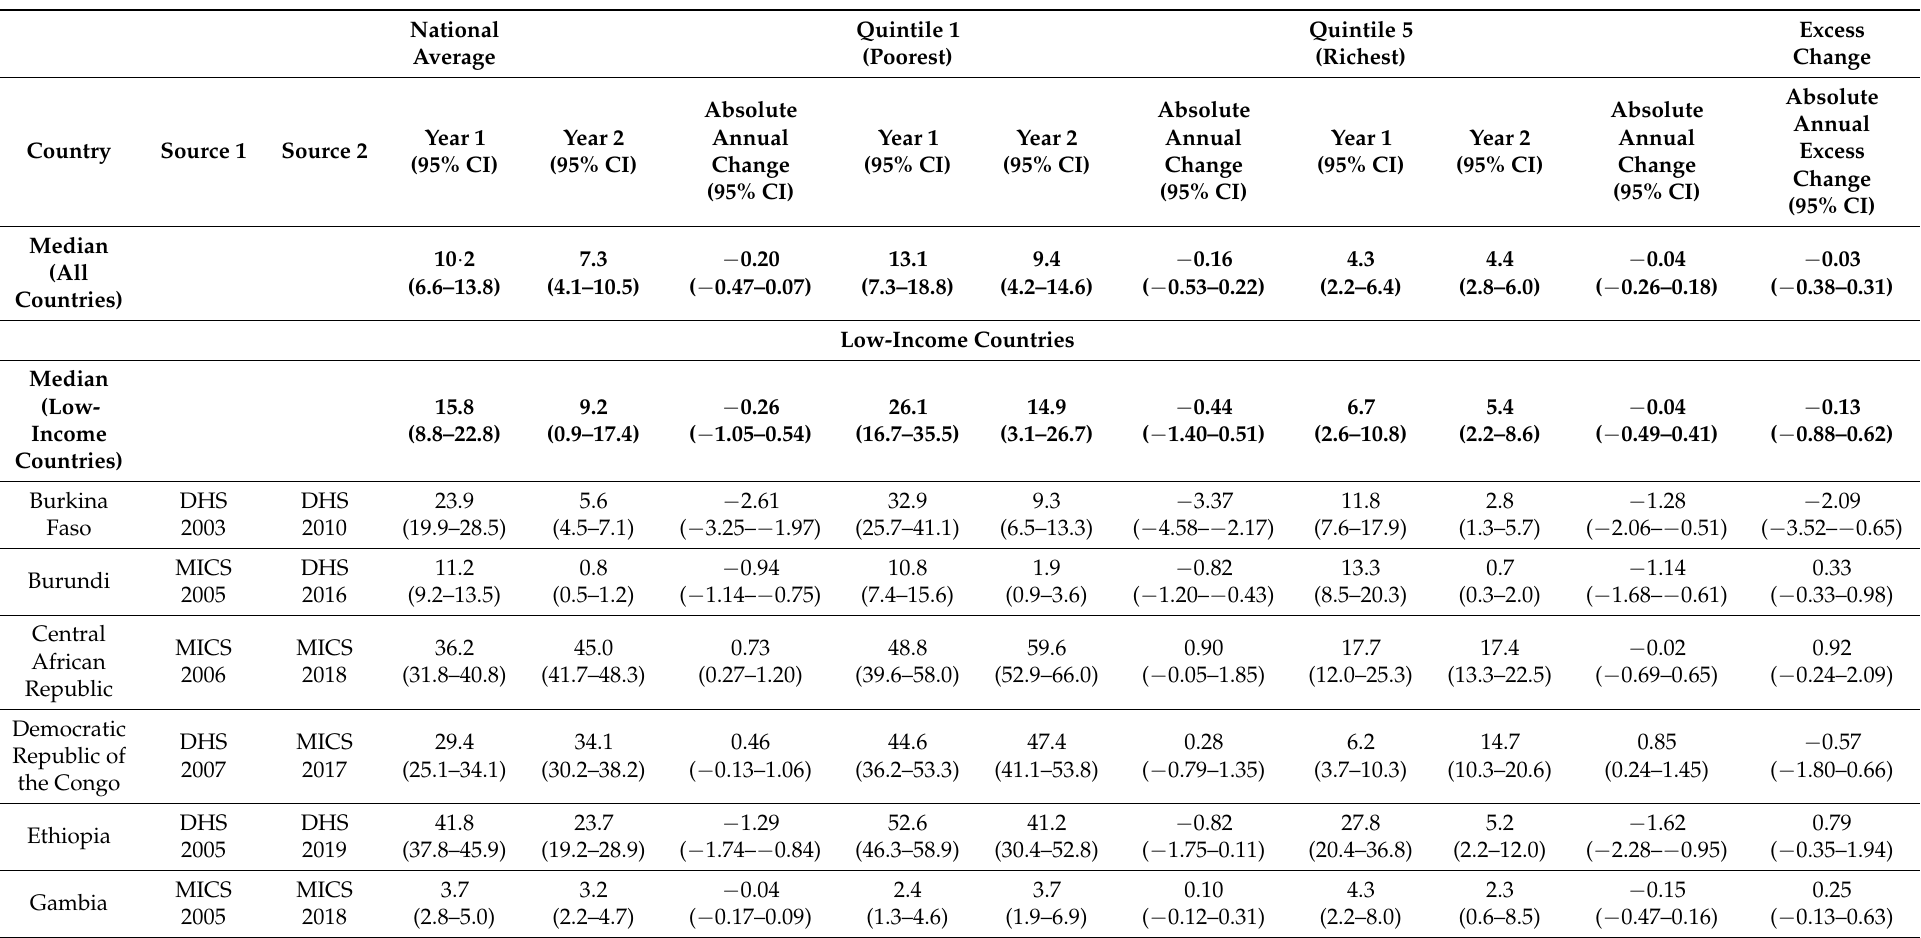
Table 2. Change over time in percentage of children aged 12–23 months who did not receive any doses of DTP-containing vaccine in 65 low- and